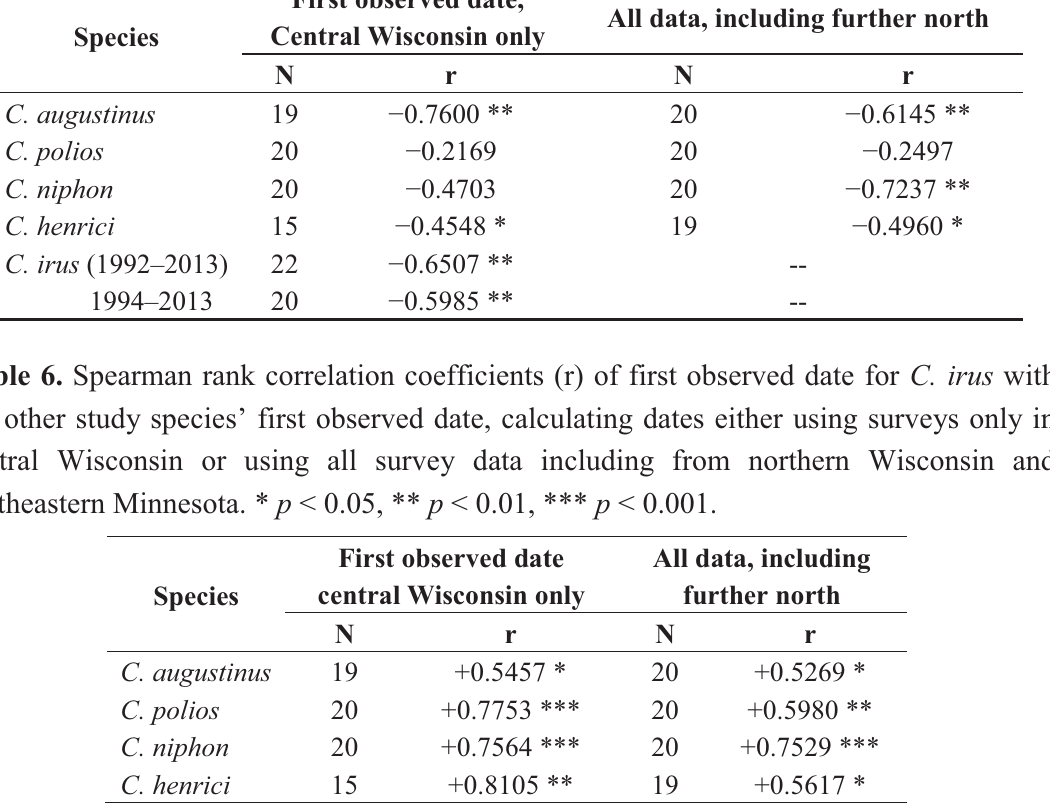
Table 5. Spearman rank correlation coefficients (r) of N days in flight period and first observed date, calculated either using surveys only in central Wisconsin or using all survey data including from northern Wisconsin and northeastern Minnesota. * p < 0.05, ** p < 0.01, *** p < 0.001.